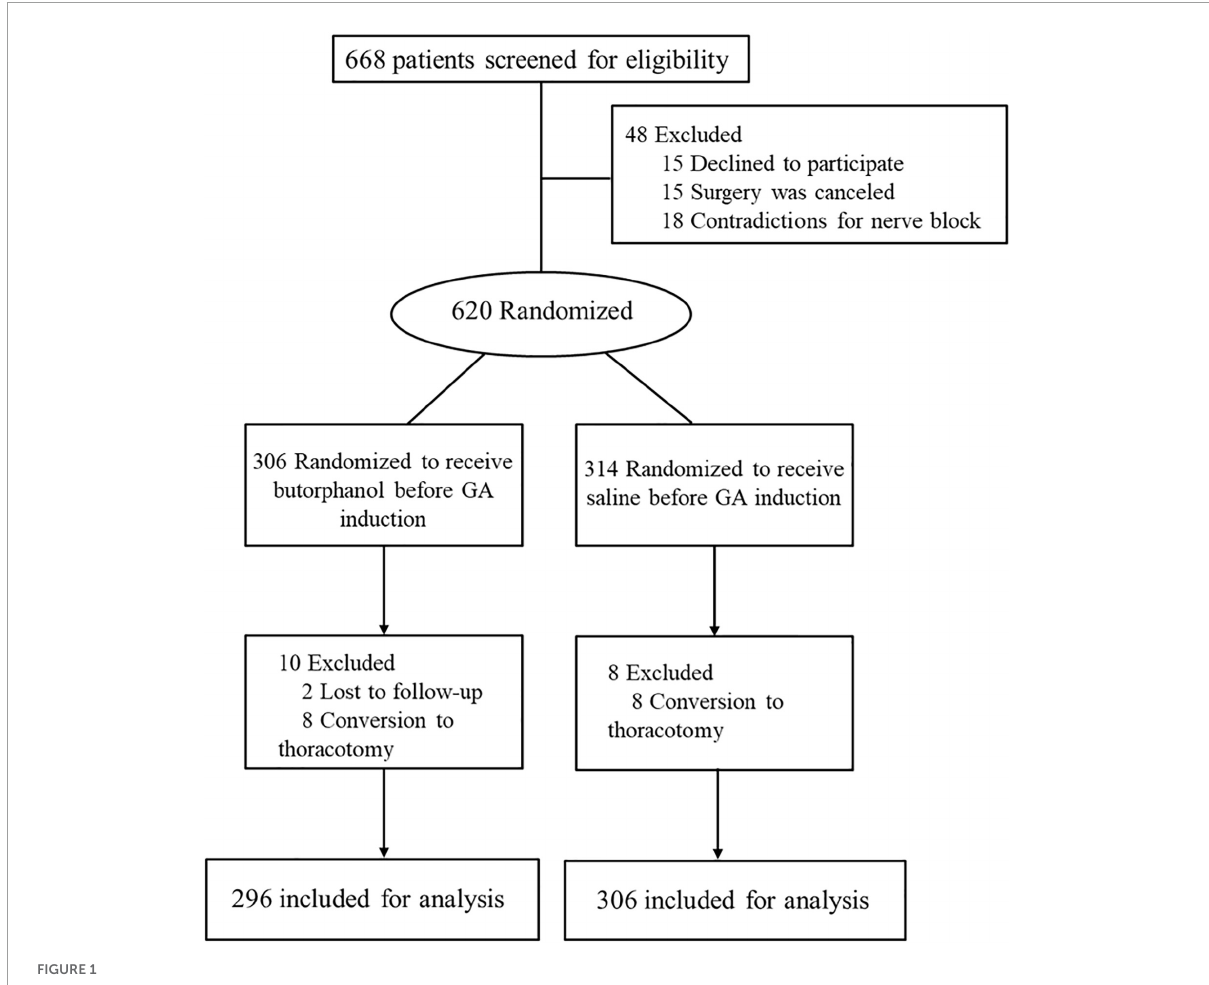
FIGURE1 CONSORT diagram for the